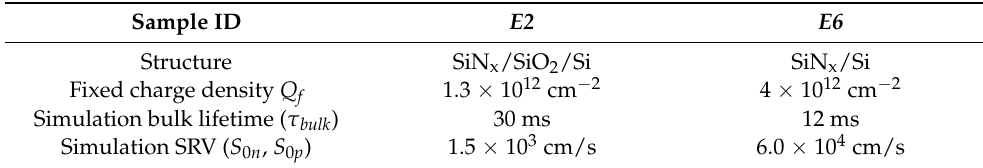
Table 3. Extracted bulk lifetime and surface recombination velocities for passivation processes E2 and E6 .